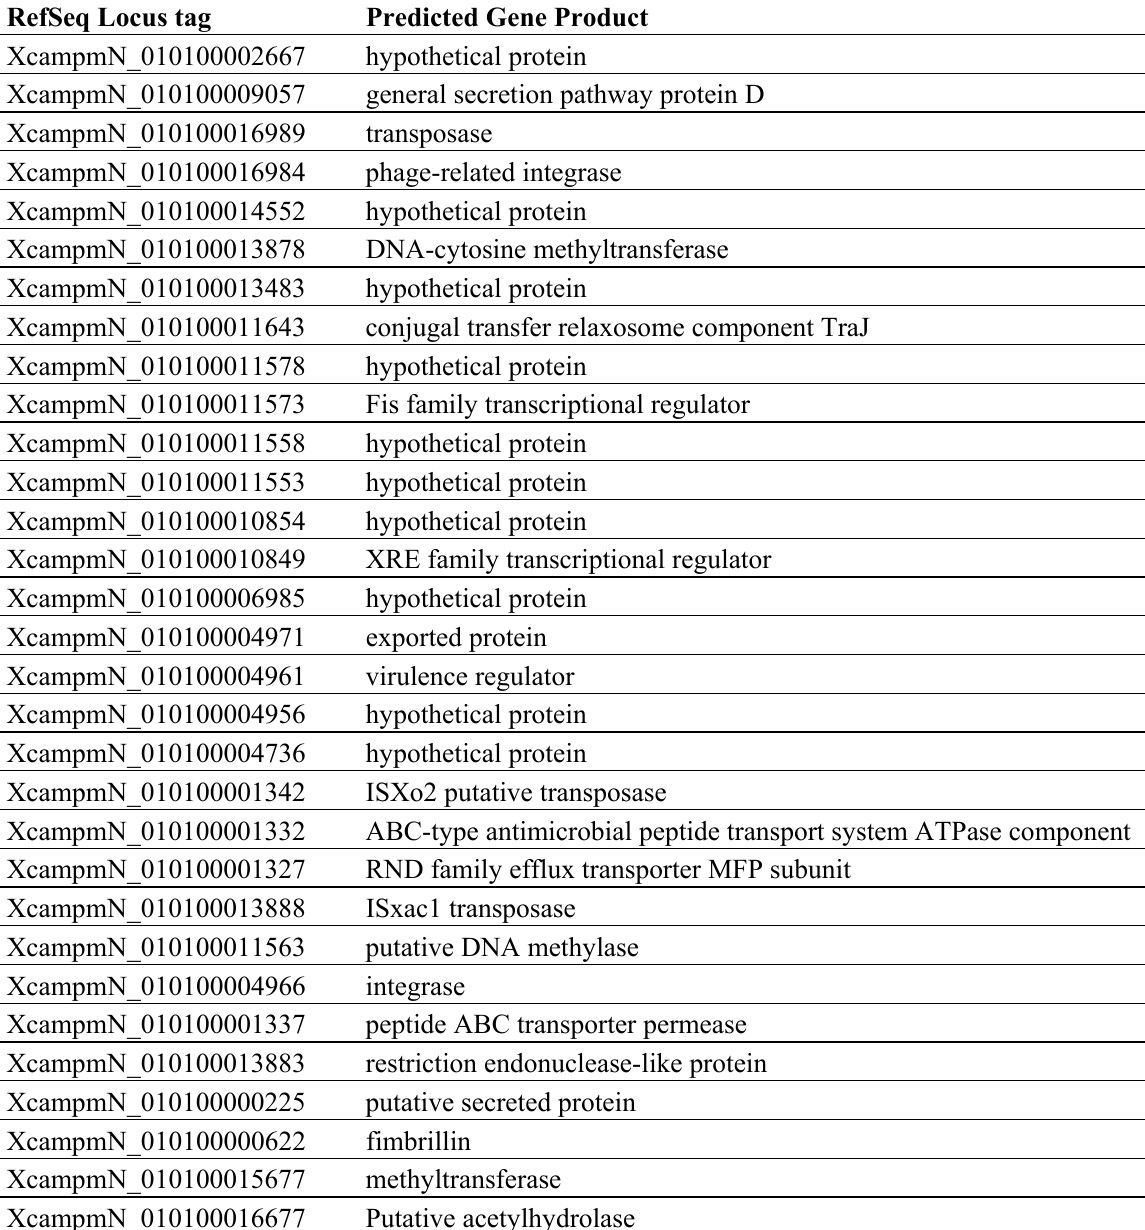
Table 2. Candidate genes for development of an Xcm -specific PCR-based assay. The listed genes conserved in all of the sequenced Xcm isolates but absent from all of the sequenced Xvv isolates. Presence or absence of each gene was assessed based on alignment of Illumina sequence reads from each isolate against the Xcm NCPPB4381 reference genome sequence (RefSeq: ACHT00000000) using BWA